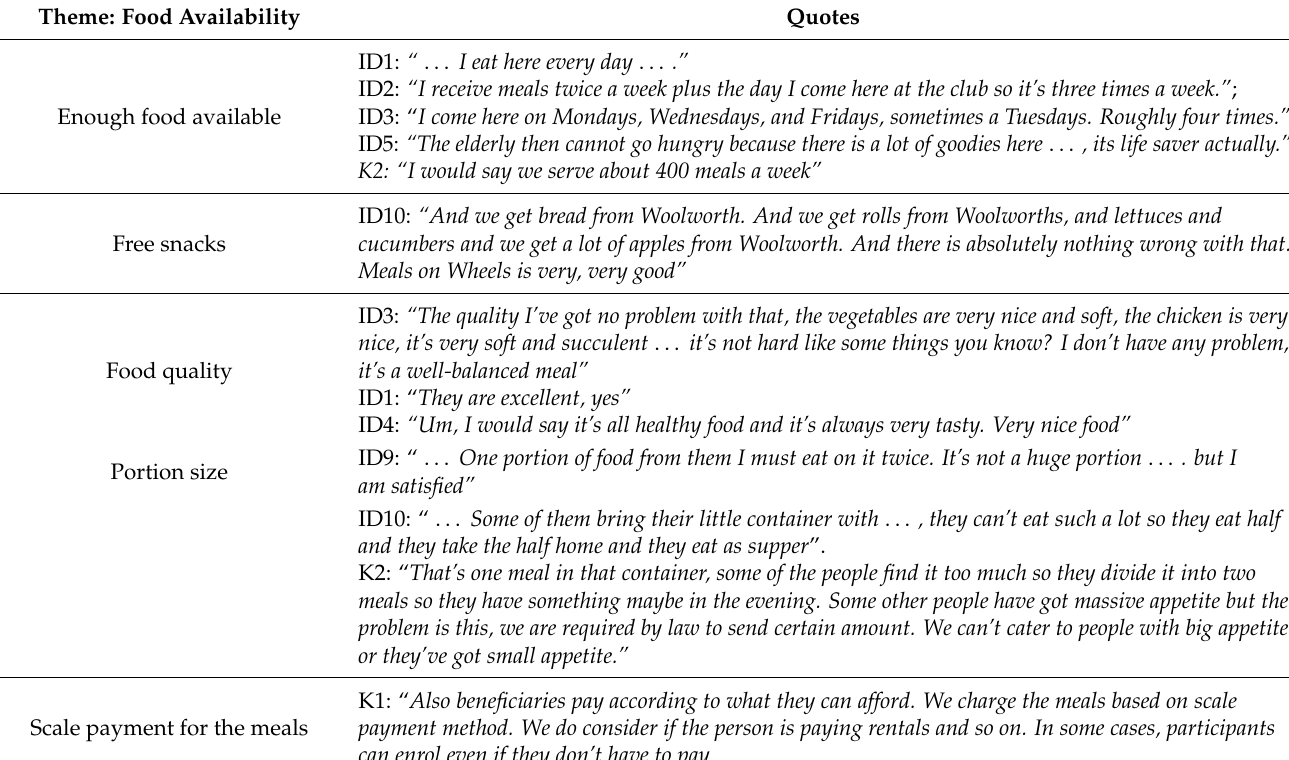
Table 3. The outcome of food availability obtained from in-depth interviews with Brooklyn MOWCS beneficiaries and some key